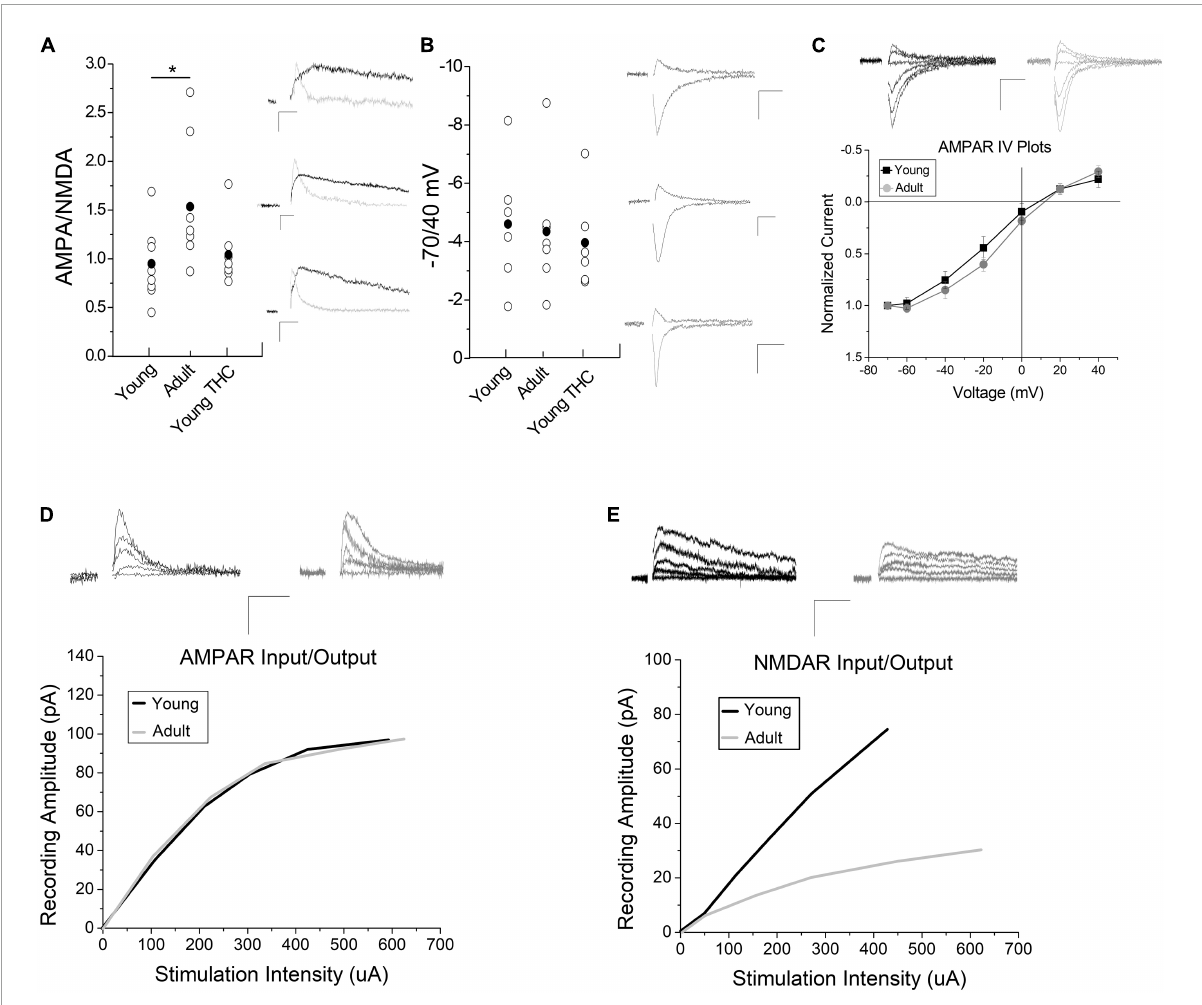
FIGURE3 Impact of development and chronic THC on AMPA/NMDA ratios. (A) AMPA/NMDA ratios are significantly higher in adult mice than young ( n = 8 young, n = 7 adults, p < 0.05). Chronic THC injection in young mice has no significant effect on AMPA/NMDA ratios when compared to naive young mice ( n = 7 young chronic THC, p > 0.1). Insets represent AMPA currents and NMDA currents at +40 mV, the latter being a subtraction of AMPA from total current (see methods for details). (B) The -70/40 ratio remains unchanged from naive young mice to adults ( n = 6 young and n = 7 adult, p > 0.1), and from naïve young mice to chronic THC injected young mice ( n = 6 chronic THC young, p > 0.1). Insets represent AMPA currents taken at -70 and +40 mV. (C) No significant difference is noted in IV plots between young and adult mice ( n = 7 for both groups, p > 0.1; ANCOVA). Rectification between the two groups at positive potentials is unchanged ( p > 0.1). Insets represent AMPA currents taken at +40, +20, 0, -20, -40, -60, and -70 mV. (D) Input/output curves of evoked AMPA currents as correlated with stimulation intensity were unchanged between age groups ( n = 15 adults, n = 13 young, p > 0.1, ANCOVA). Curves were created by post hoc analysis of raw data using two-minute averages of EPSCs comparing the amount of current evoked in an AMPA or NMDA only EPSCs at +40 mV compared to